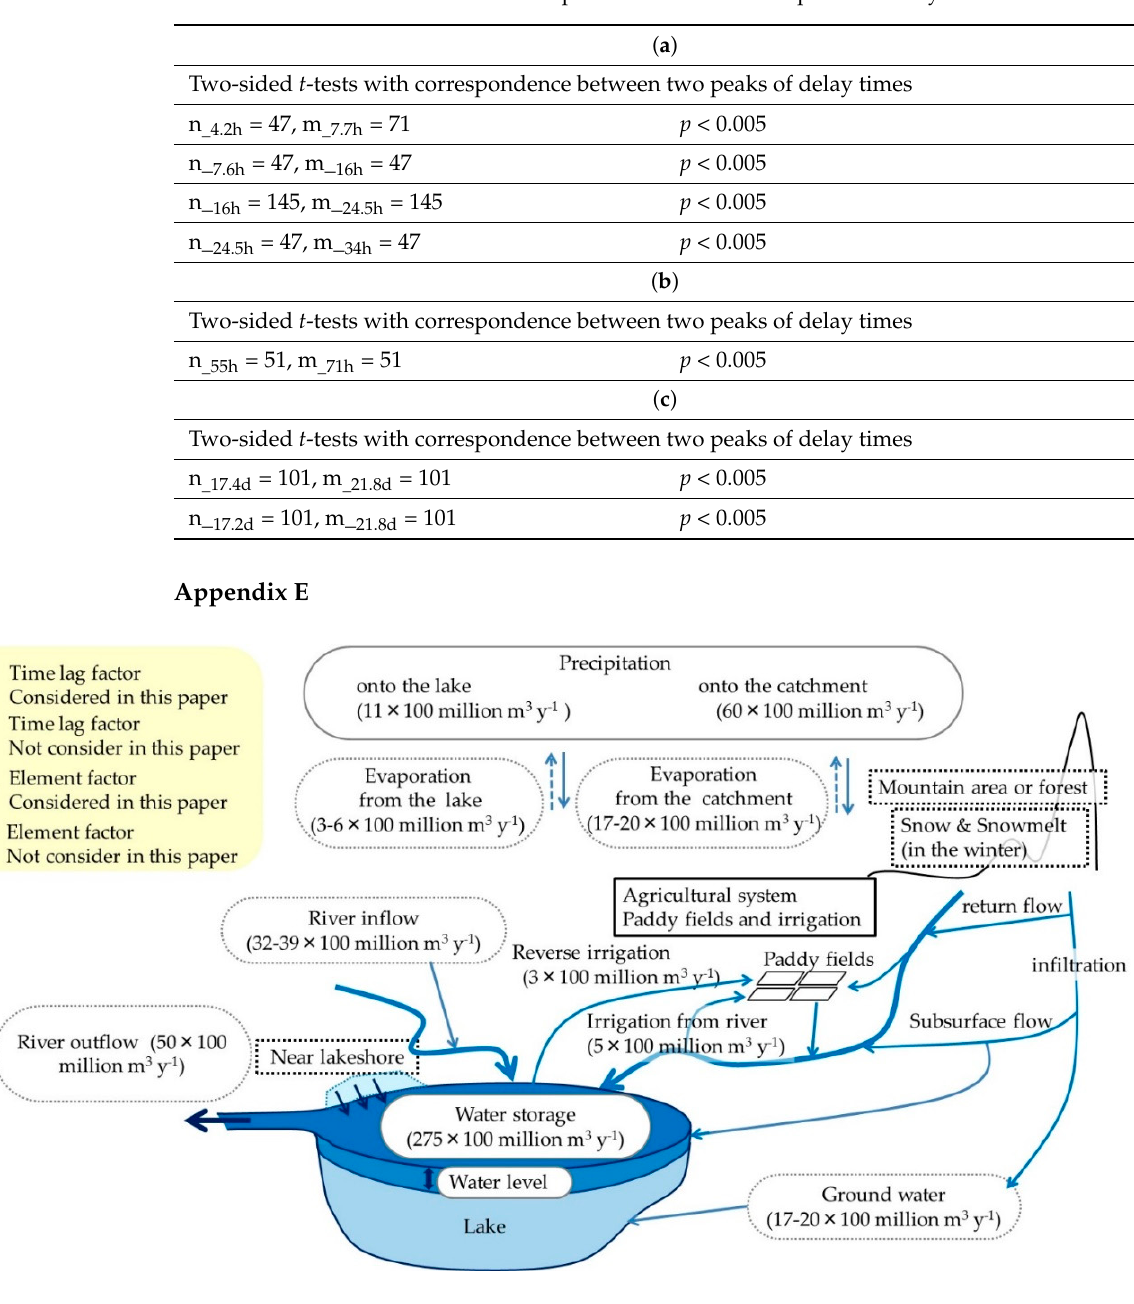
Figure A3. Schematic model showing the water flow from the catchment area to Lake Biwa and water balance. The values of the water balance were obtained from the literature [31,32].